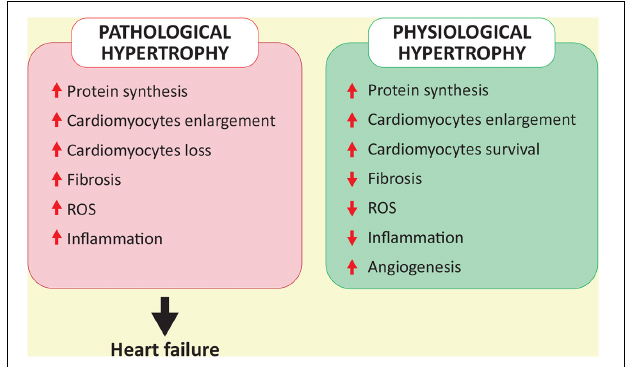
FIGURE 2 | A schematic representation of the comparison between pathological and physiological